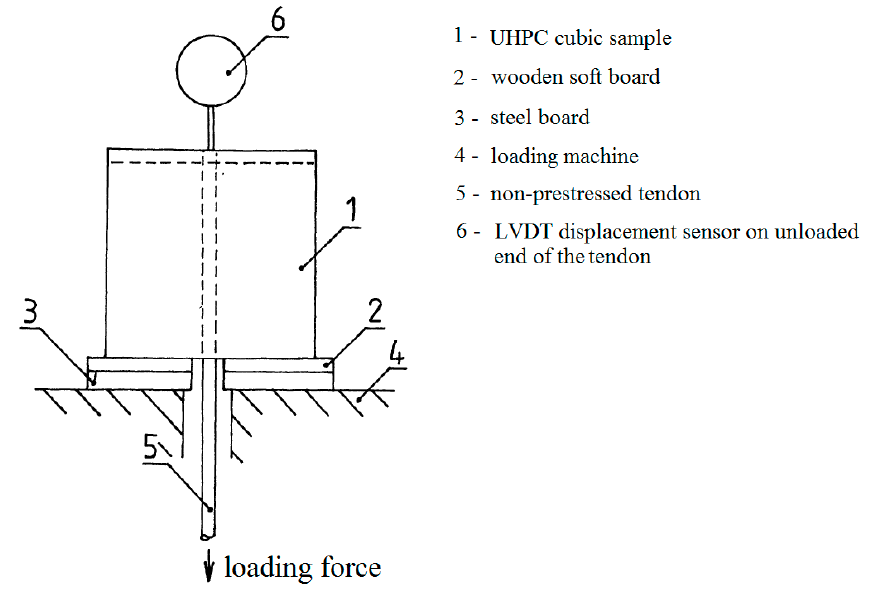
Figure 6. Example of the UHPC samples with prestressing reinforcement in the furnace.